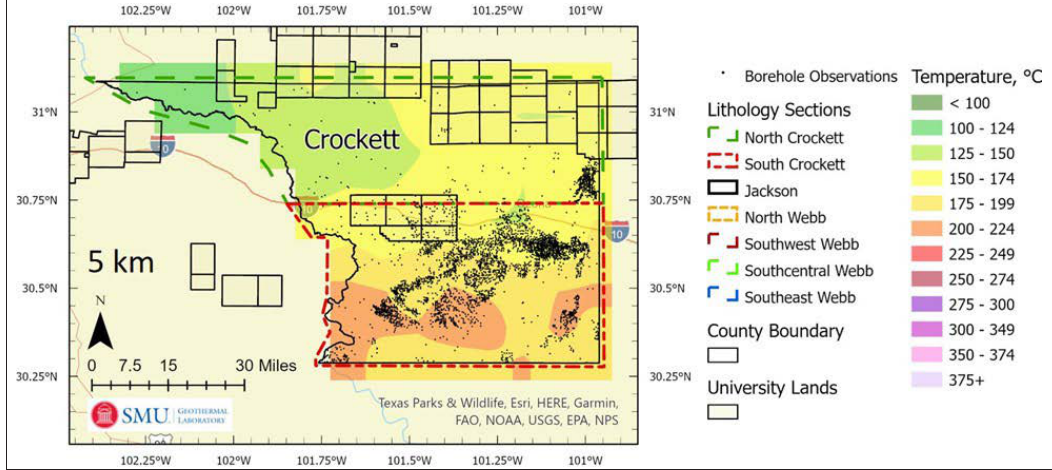
Figure 6. Crockett County temperature at 5.0 kilometers (km; 16,400 feet) depth. A similar trend of warmer temperatures going from the northwest to south and east is visible. Surface well locations are displayed as small black dots for reference but are not this deep (Figure 1). The majority of Crockett County is over 150 °C (300 °F) at this